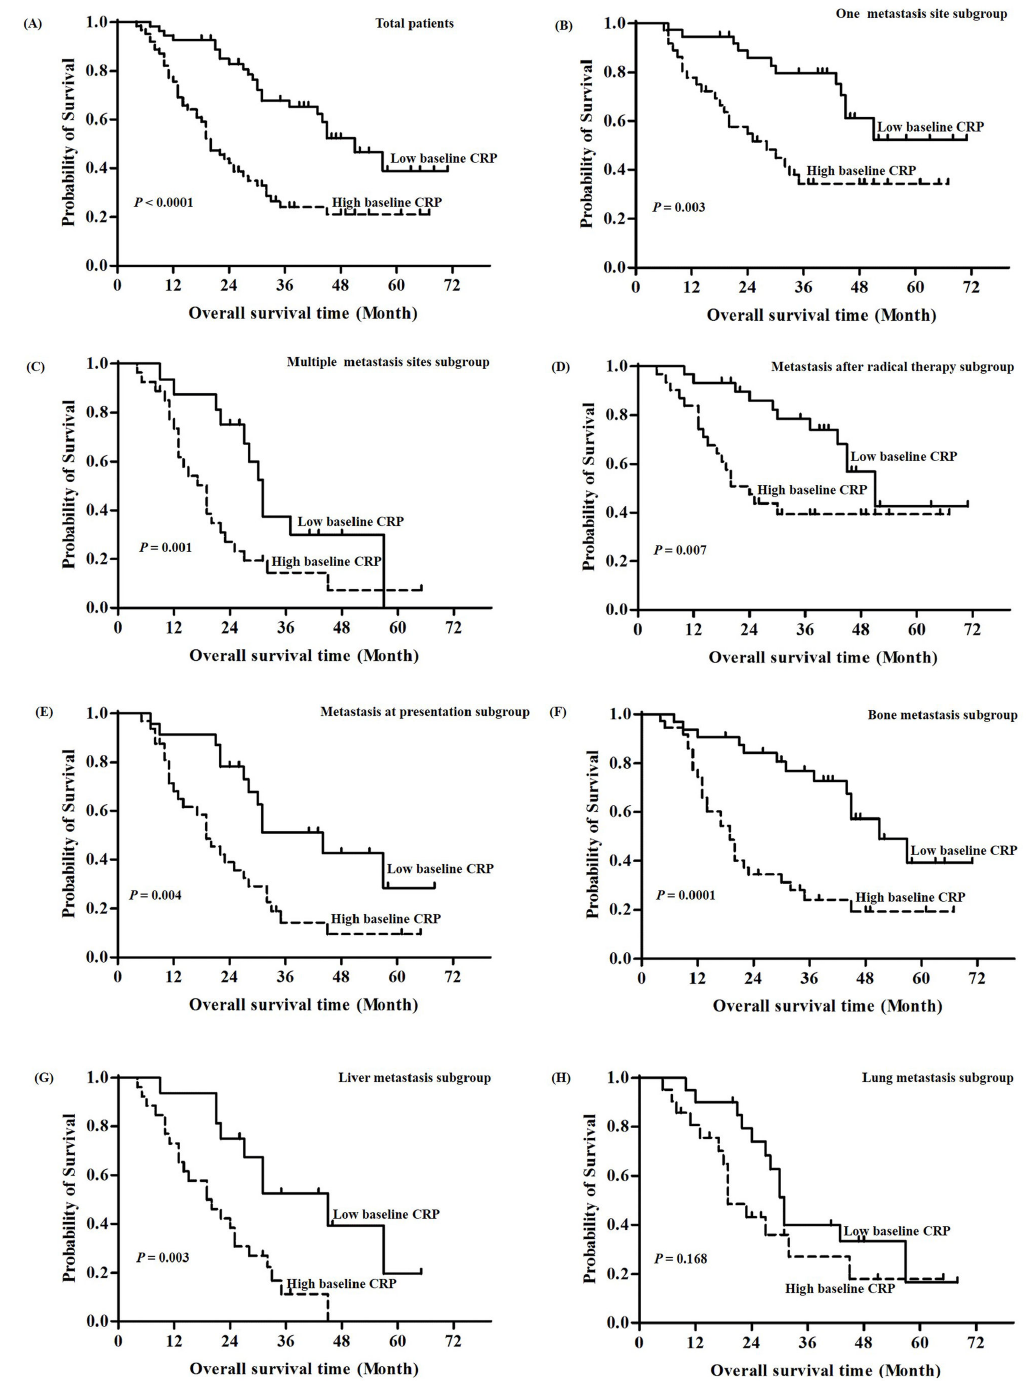
Figure 3. Kaplan-Meier analysis of overall survival according to baseline C-reactive protein (CRP) levels. (A) Overall survival in all patients according to baseline CRP levels ( P < 0.0001). (B) Kaplan-Meier analysis of overall survival in one metastasis subgroup ( P = 0.003). (C) Kaplan-Meier analysis of overall survival in multiple metastasis sites subgroup ( P = 0.001). (D) Kaplan- Meier analysis of overall survival in metastasis after radical therapy subgroup ( P = 0.007). (E) Kaplan-Meier analysis of overall survival in metastasis at presentation subgroup ( P = 0.004). (F) Kaplan-Meier analysis of overall survival in bone metastasis subgroup ( P = 0.0001). (G) Kaplan-Meier analysis of overall survival in liver subgroup ( P = 0.003). (H) Kaplan-Meier analysis of overall survival in lung subgroup. The log-rank test was used to calculate P-values ( P = 0.168). doi: 10.1371/journal.pone.0076958.g003 PLOS ONE |